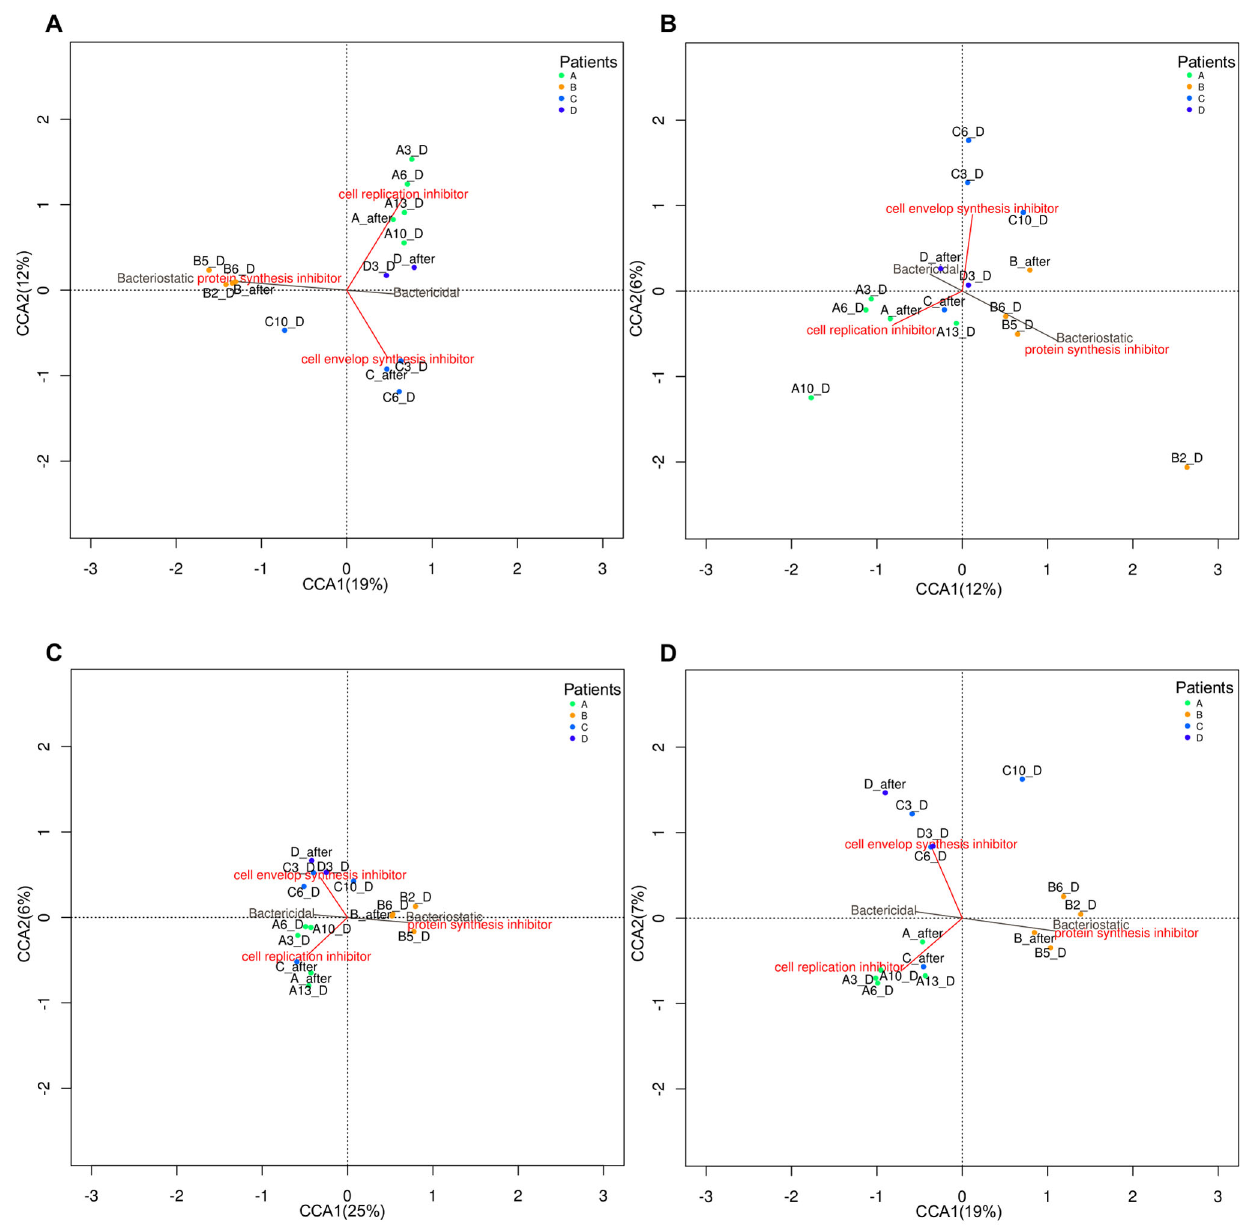
Figure 3. Canonical Correspondence Analysis (CCA) of the patients A, B, C and D in the follow-up study. ( A) total microbiota, (B) active microbiota, (C) genes and (D) gene taxonomy. The antimicrobial effect is represented as a vector with two levels (bactericidal and bacteriostatic). The mode of AB action is represented as a vector with three levels (cell envelop synthesis inhibitor, cell replication inhibitor and protein synthesis inhibitor).